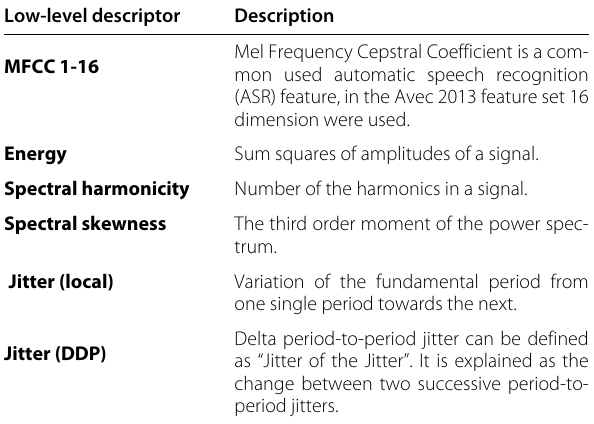
Table 13 Overlapping low-level descriptors in language pairs that are in the top 150 MRMR-selected features Low-level descriptor